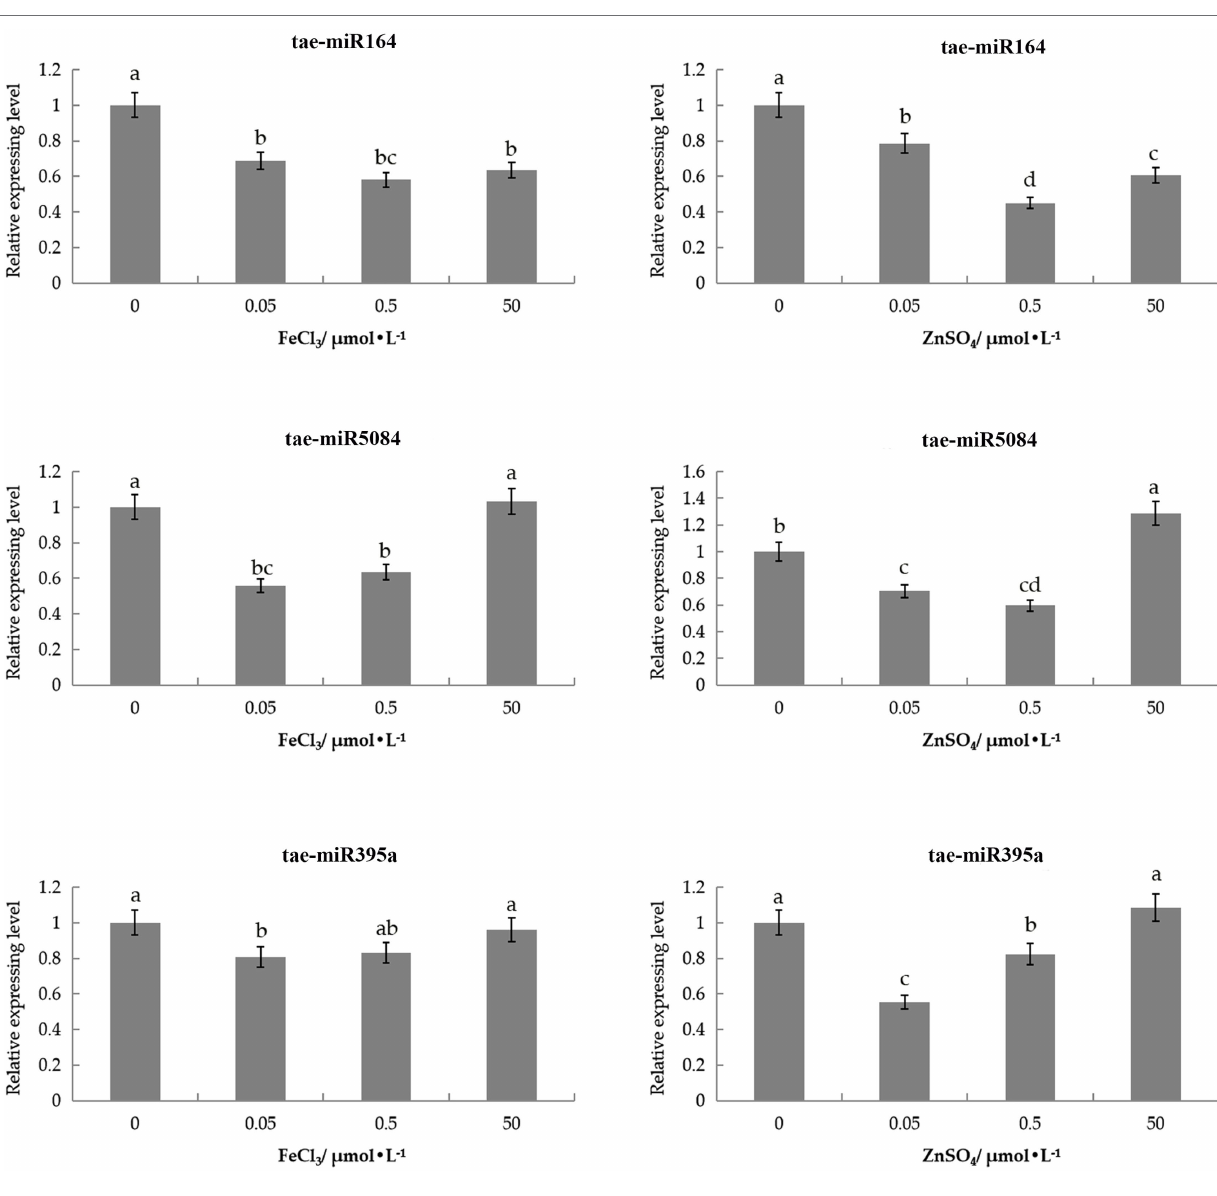
FIGURE 6 | Expression patterns of three tae-miRNAs under Zn and Fe stress through qRT-PCR analysis. The expression level was calculated according to the 2 −∆∆ C t method. Relative miRNA abundance of each gene was normalized with the expression of 0 h. Error bars indicate the standard deviations, and different letters are significantly